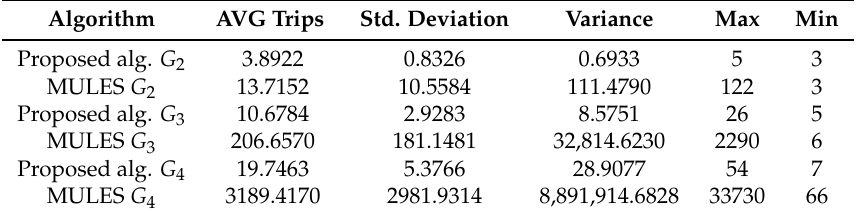
Table 7. Results of our proposed algorithm compared with MULE for DFGs G h of size h = (2, 3, 4). Algorithm AVG Trips Std. Deviation